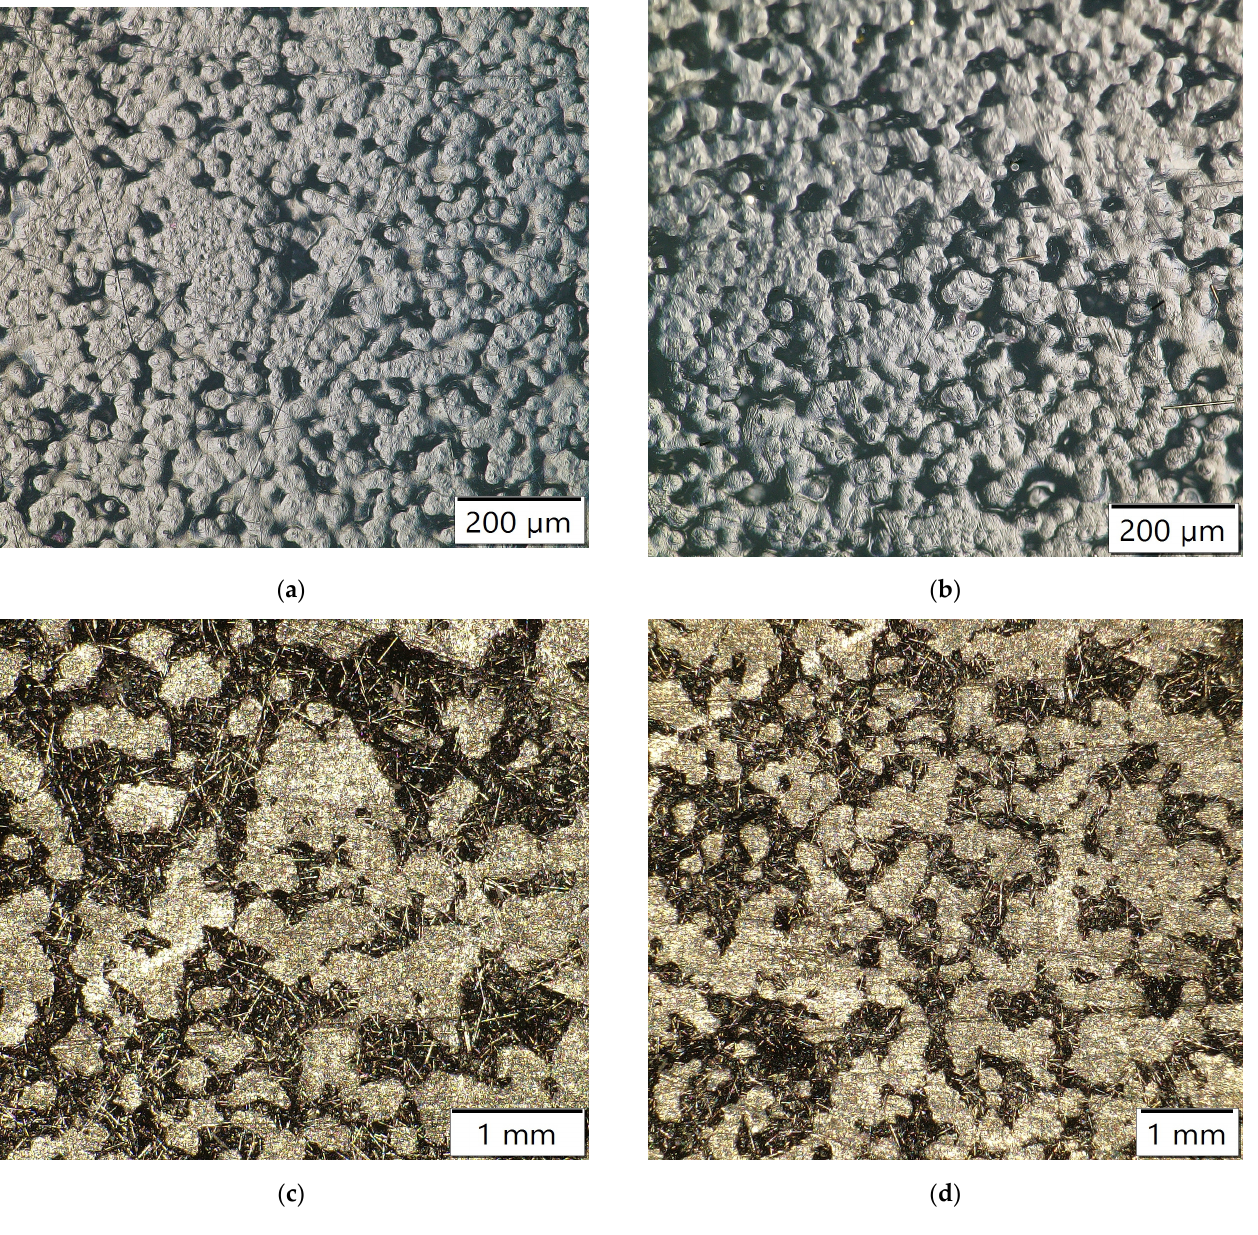
Figure 14. Surface images using optical microscopy: ( a ) PE, ( b ) plasma PE, ( c ) 7% CF/non-plasma PE and ( d ) 7% CF/plasma PE combinations.